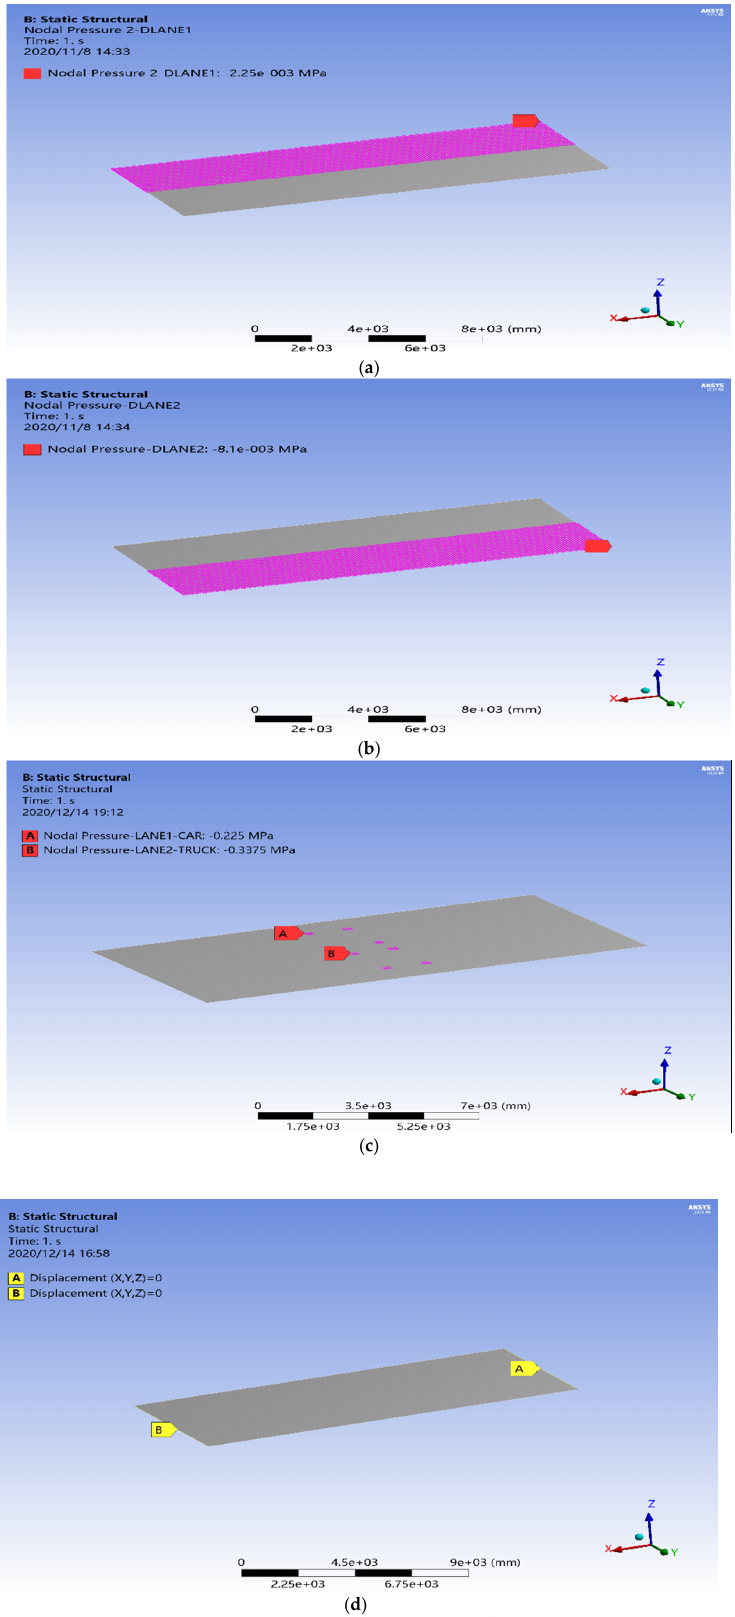
Figure 1. ( a ) Distributed load on lane 1 ( b ) Distributed load on lane 2; ( c ) Position of vehicles on the lane; ( d ) Boundary conditions.